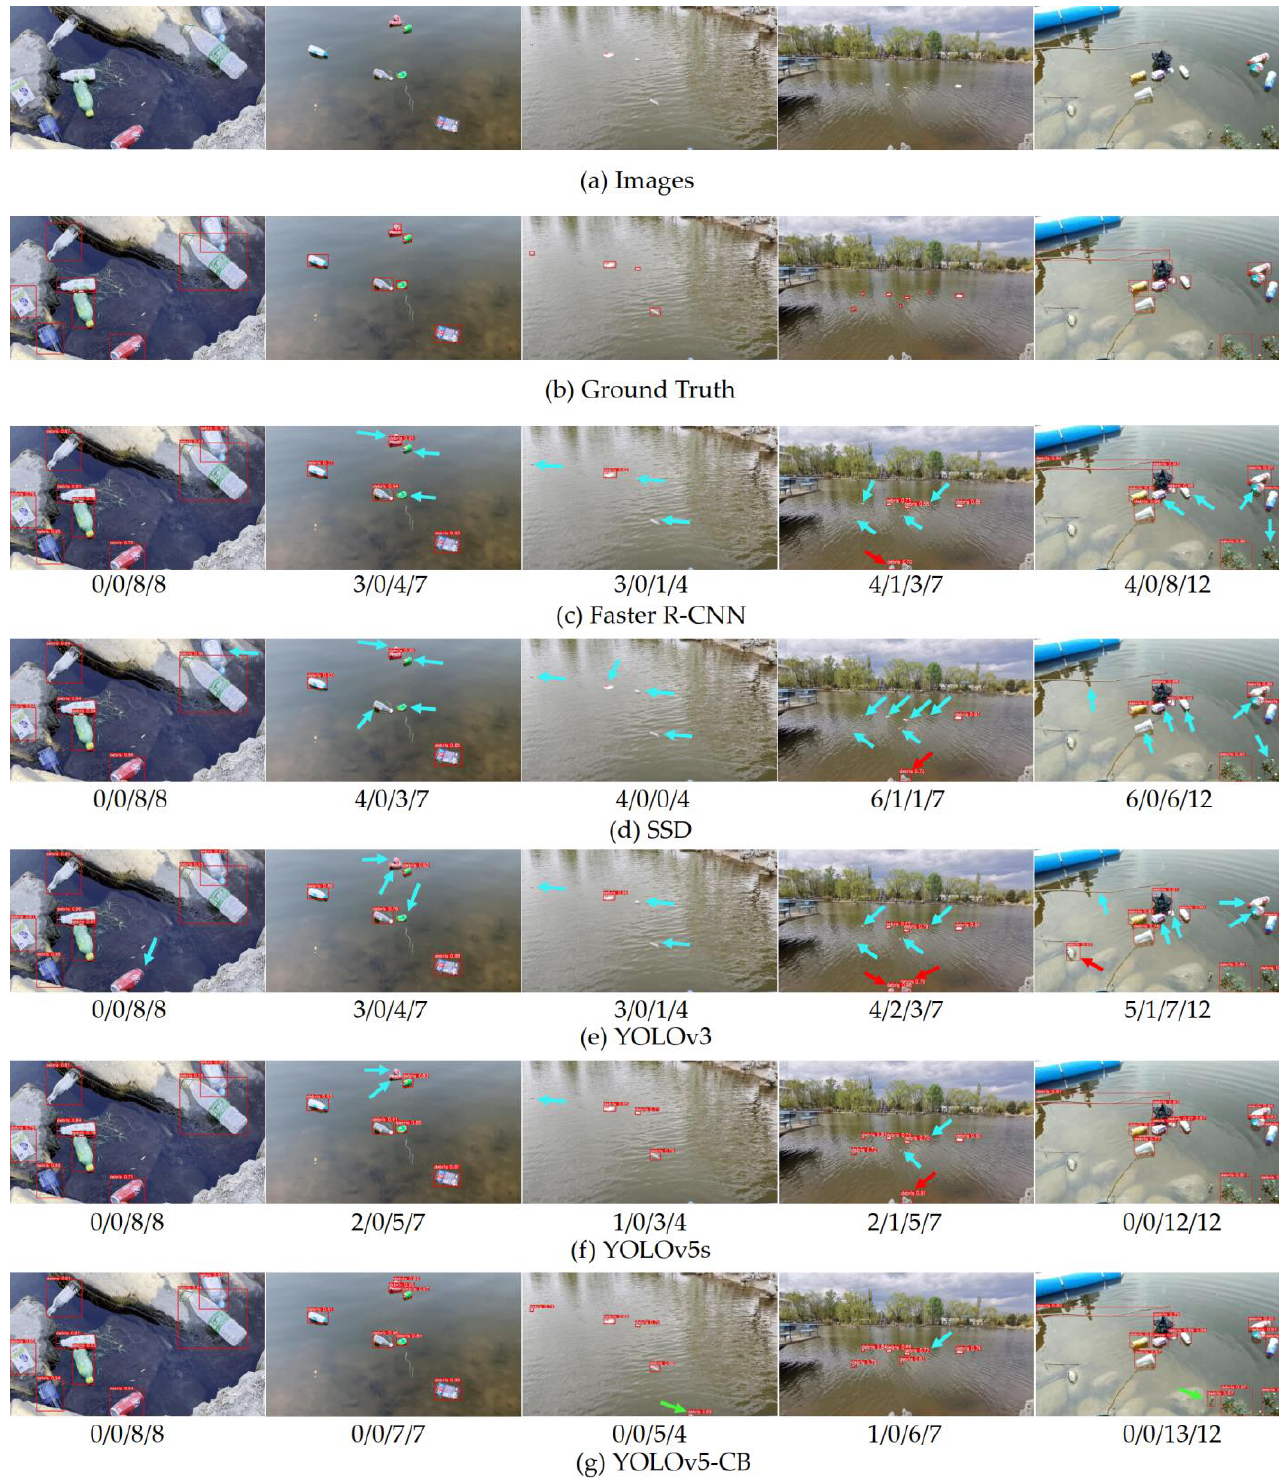
Figure 7. Examples of floating debris detection results for five methods on the SWFD dataset, where the red bounding box represents the result of debris detection, blue arrows highlight some false negative results, red arrows highlight some false positive results, and green arrows highlight some true positives that are not annotated in ground truth. The bottom of the subgraph of each row marks the detected object state, which are false negative/false positive/true positive/total numbers of objects to be checked.